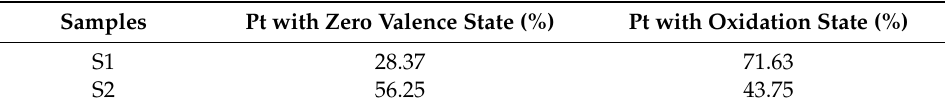
Figure 4. The UV–Vis diffuse reflectance spectra of La 2 O 3 , S1 and S2.